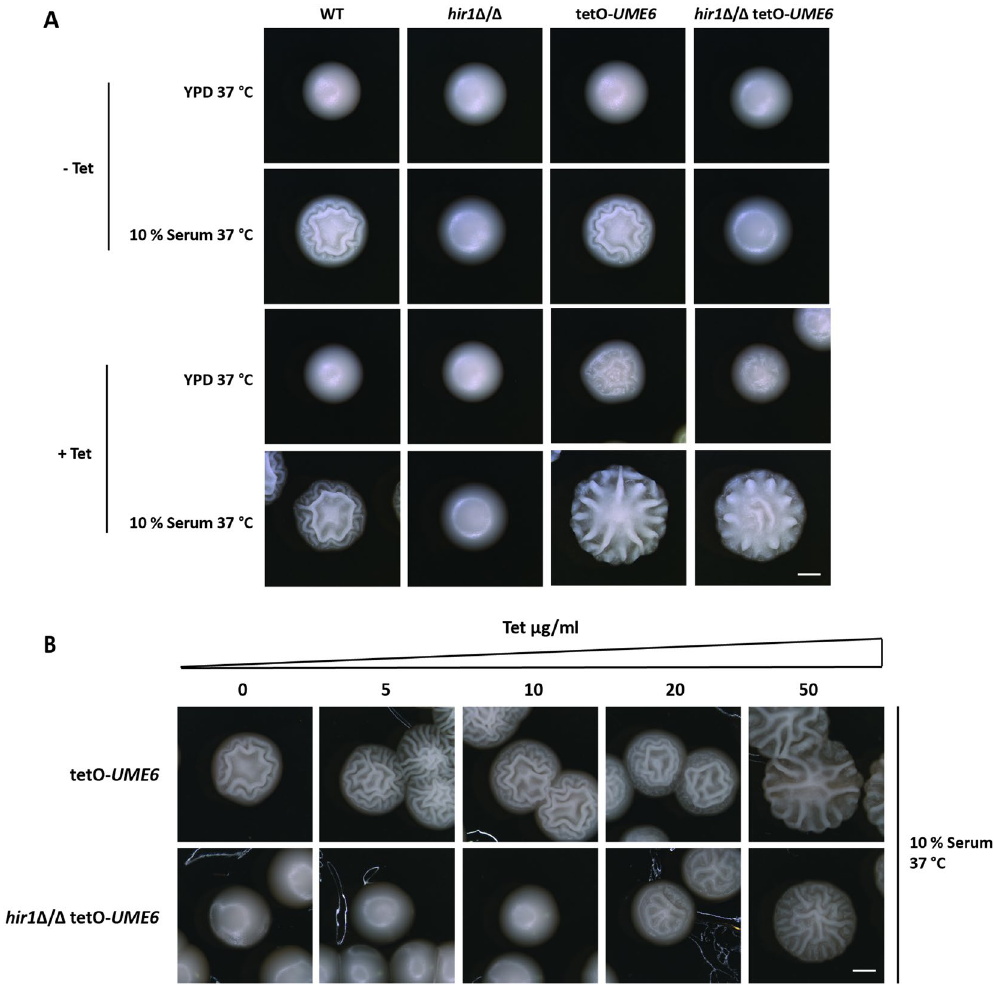
Figure 6. Ectopic expression of UME6 restores hyphal formation in the absence of HIR1 . ( A , B ) The UME6 gene was placed under conditional expression control using the tet-ON system 70 . Expression was triggered by adding 50 µ g/ml tetracycline ( A ) or various concentrations of tetracycline ( B ). Colony morphology was assessed after growth for 2 days at 37 °C. Scale bar corresponds to 1